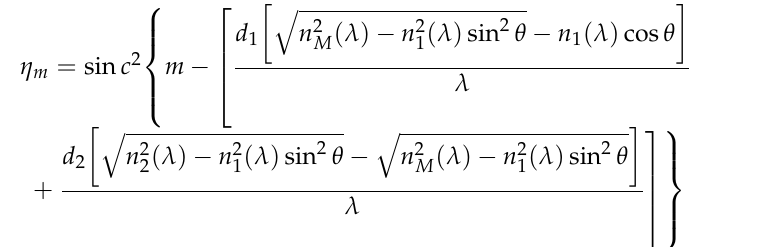
Figure 4. BIADE versus the wavelength after optimization of double-layer DOEs for substrates con- sisting of different material combinations.